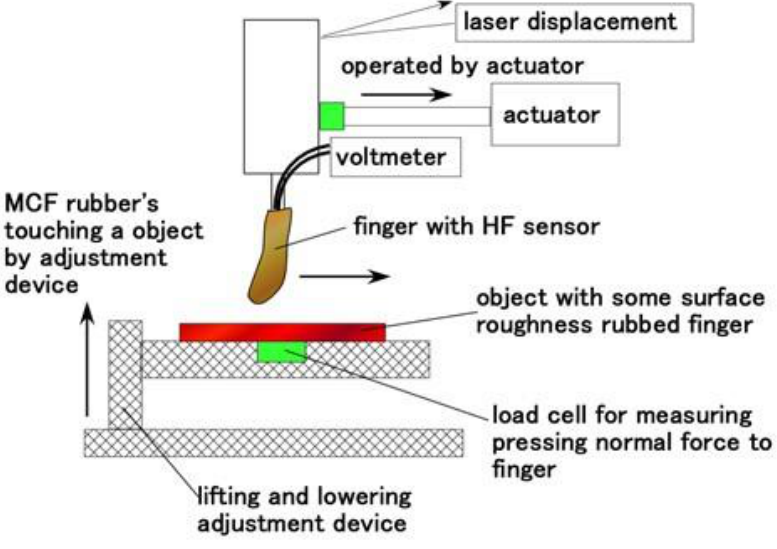
Figure 17. Schematic diagram of the experimental apparatus of stroking a body with some surface